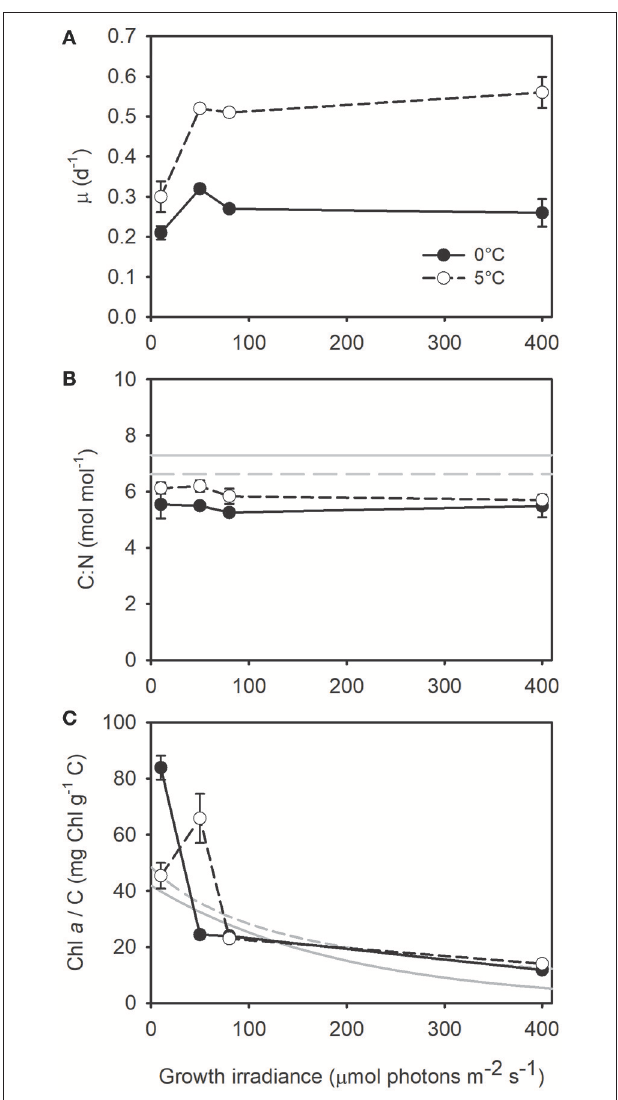
FIGURE 1 | (A) Growth rate, (B) carbon to nitrogen ratio, and (C) Chl a to carbon ratio as a function of growth irradiance in Thalassiosira gravida cells acclimated to 0 ◦ C (closed circles) and 5 ◦ C (open circles). Each data point is the mean of 3 independent cultures, error bars represent standard deviations. In (B) the continuous gray line represent the mean C:N ratio in diatoms computed by Sarthou et al. (2005), and the dotted line represent the Redfield ratio (Redfield, 1934). In (C) the gray lines represent the relationship between Chl a /C and growth irradiance as modeled at 20 ◦ C by Cloern et al. (1995) (Chl a /C = 0.003 + 41.861 exp(-0.00509 E), continuous line) and Geider (1987) (Chl a /C = 1/(0.0206 + 0.00015 E), dashed